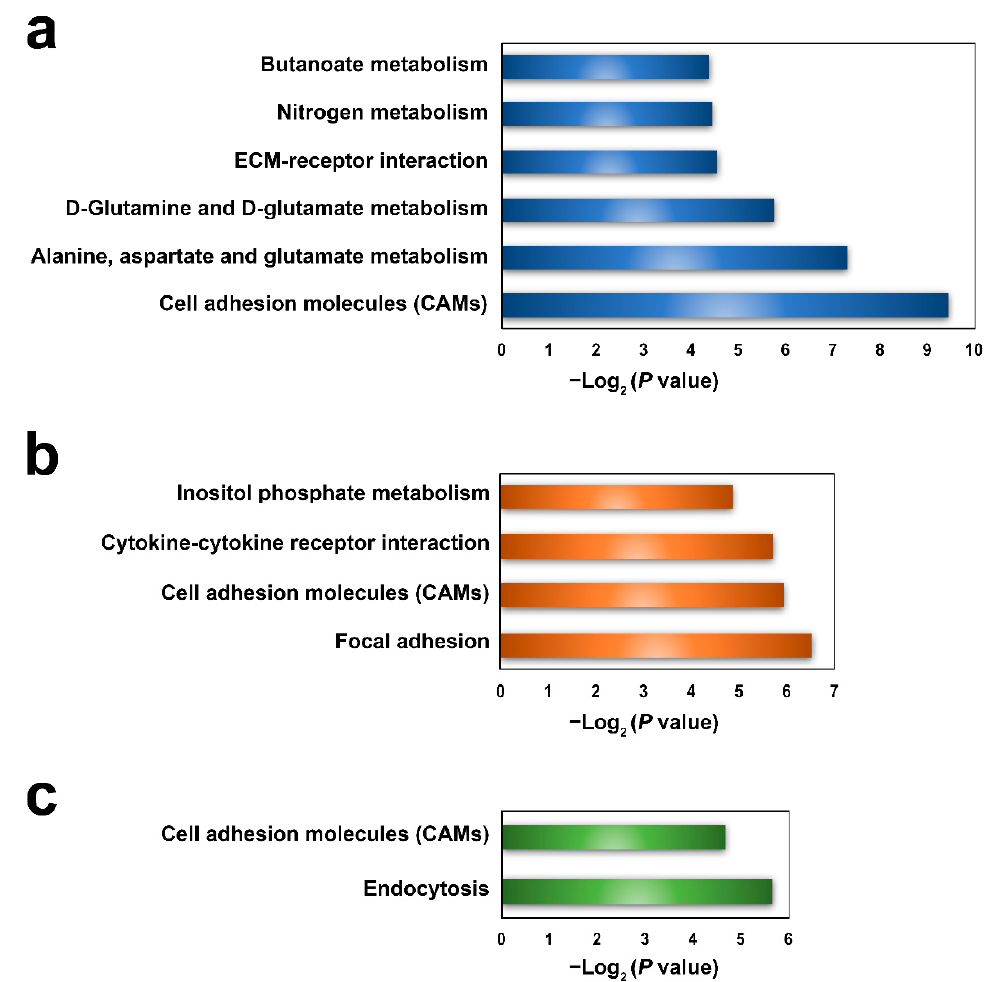
Figure 3. Differentially expressed circRNAs (DEcirs) induced by V. anguillarum infection at different time points. ( a ) Num- ber of DEcirs at 6, 12, and 24 h post-infection (hpi). “Up” and “Down” indicate up- and downregulated expression, re- spectively. ( b ) Venn diagram showing overlapping DEcirs at different time points. ( c ) Heat-map showing the expression patterns of DEcirs in different groups at different time points. For convenience, “C6”, “C12”, and “C24” indicate the control groups at 6, 12, and 24 h post-infection (hpi), respectively; “V6”, “V12”, and “V24” indicate the V. anguillarum -infected groups at 6, 12, and 24 hpi, respectively.